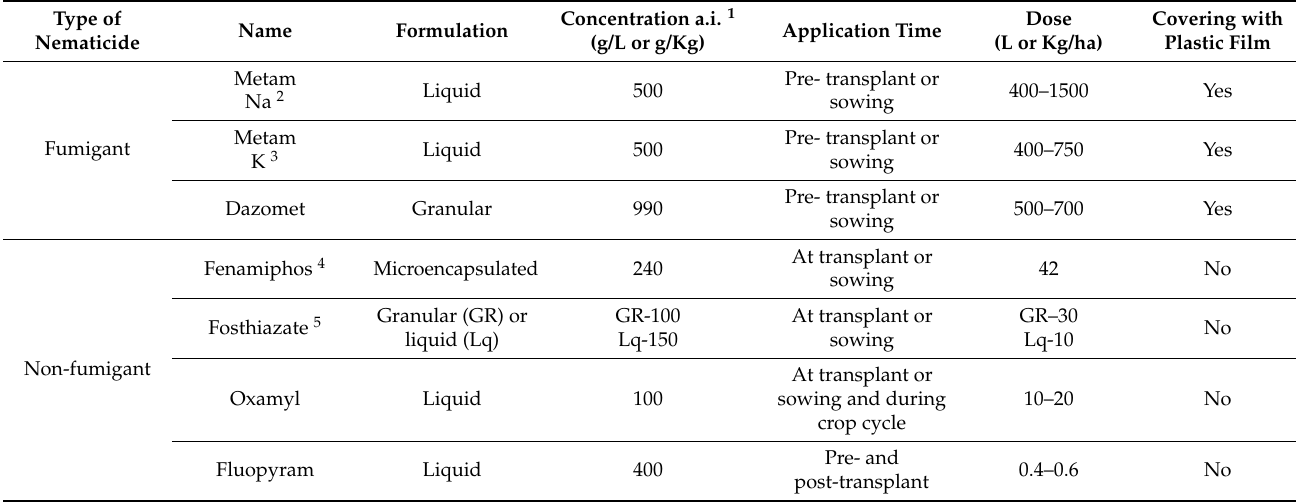
Table 2. Fumigants and non-fumigants authorized in the C Zone of the EU against plant-parasitic nematodes (approved for use under EC Reg. 2009/1107 according to PPDB: Pesticide Properties Data